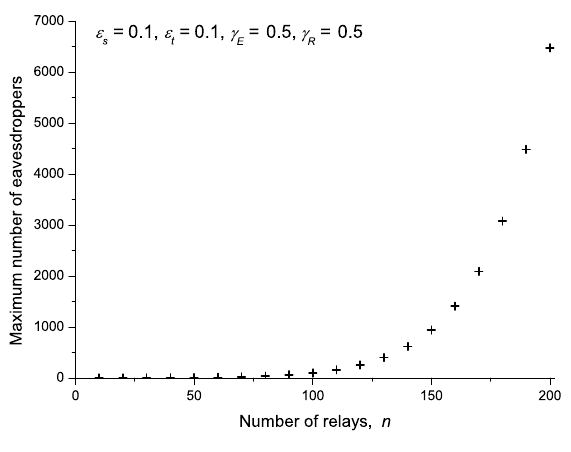
Figure 3. Maximum number of eavesdroppers for Protocol 1 vs.